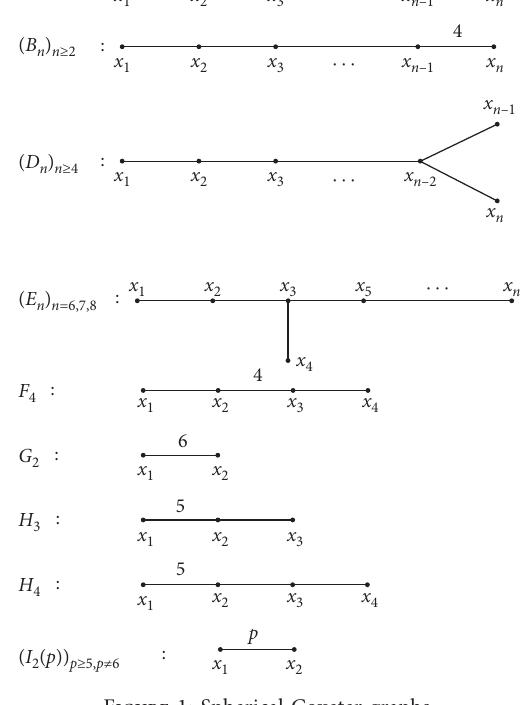
Figure 1: Spherical Coxeter graphs.